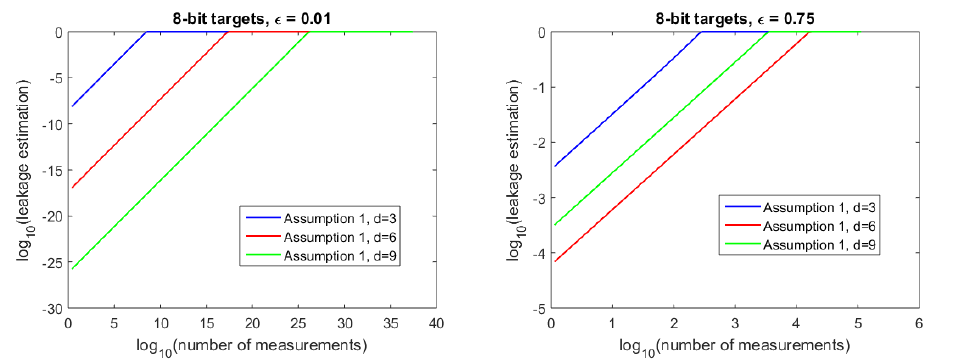
Figure 15: Leakage bounds for the factor graph of Figure 13 (leakage assumption